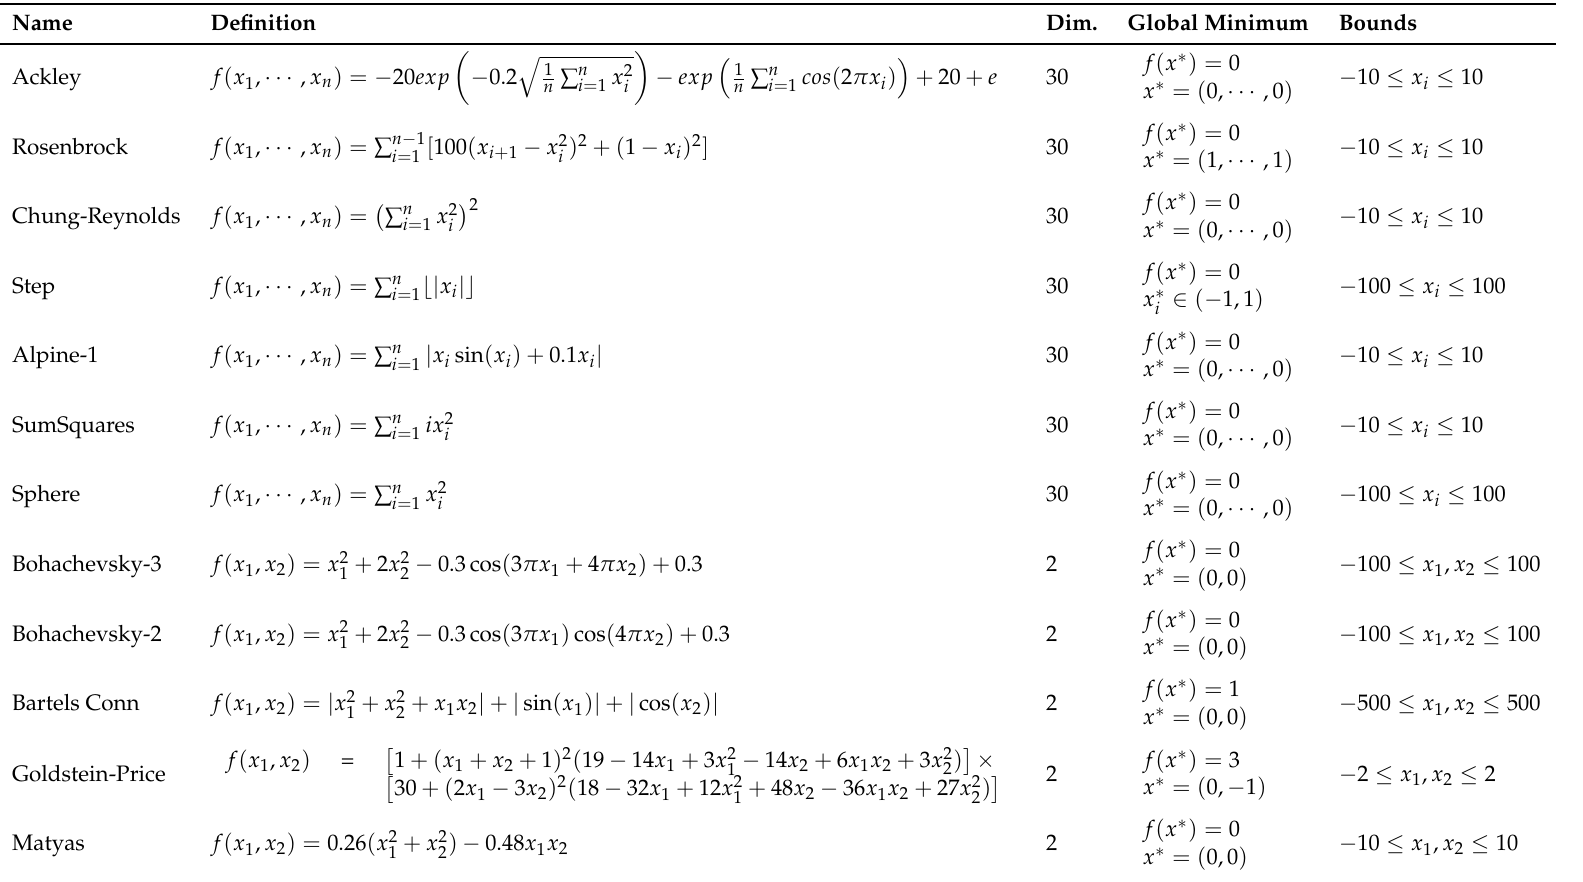
Table 1. Benchmark